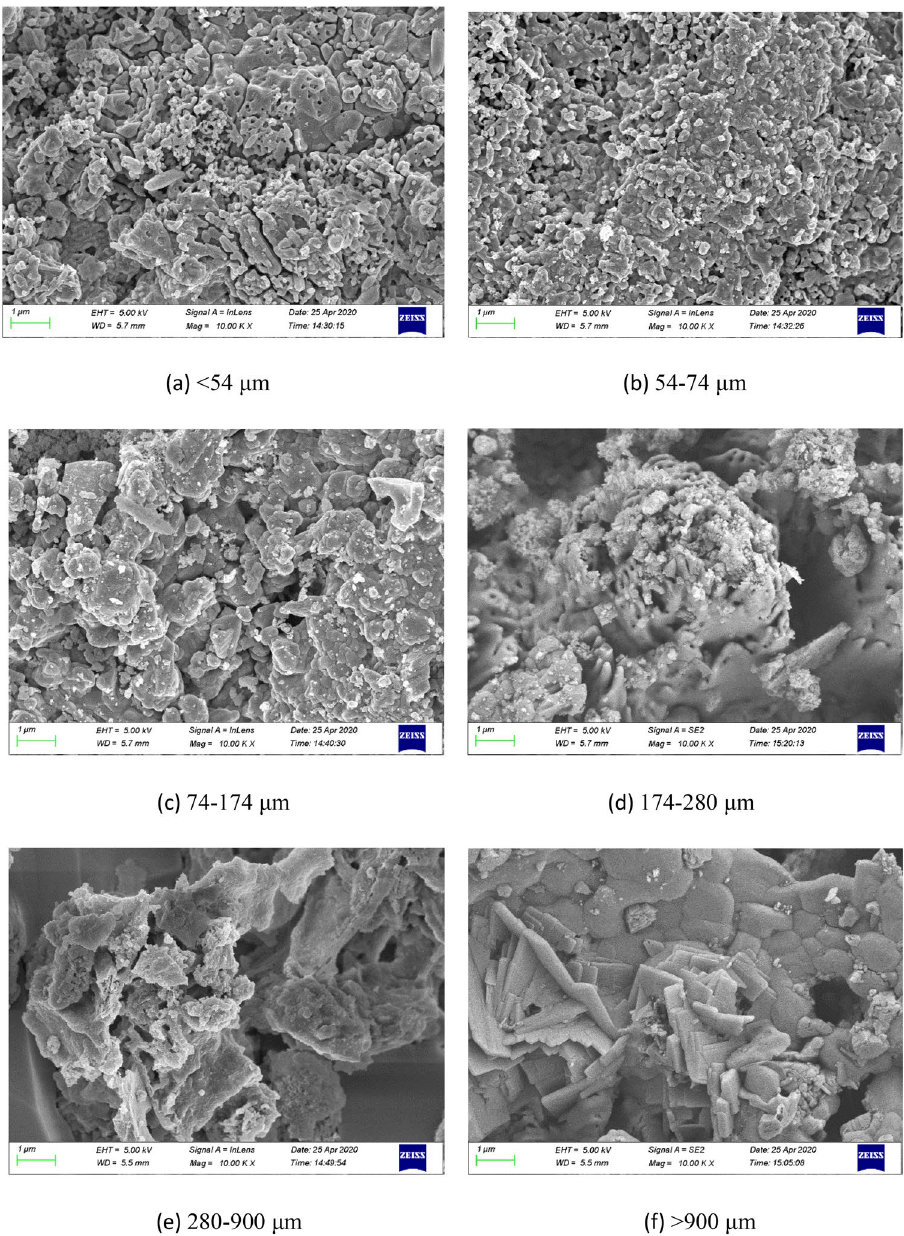
Figure 4. SEM micrographs of fly ash samples with different particle